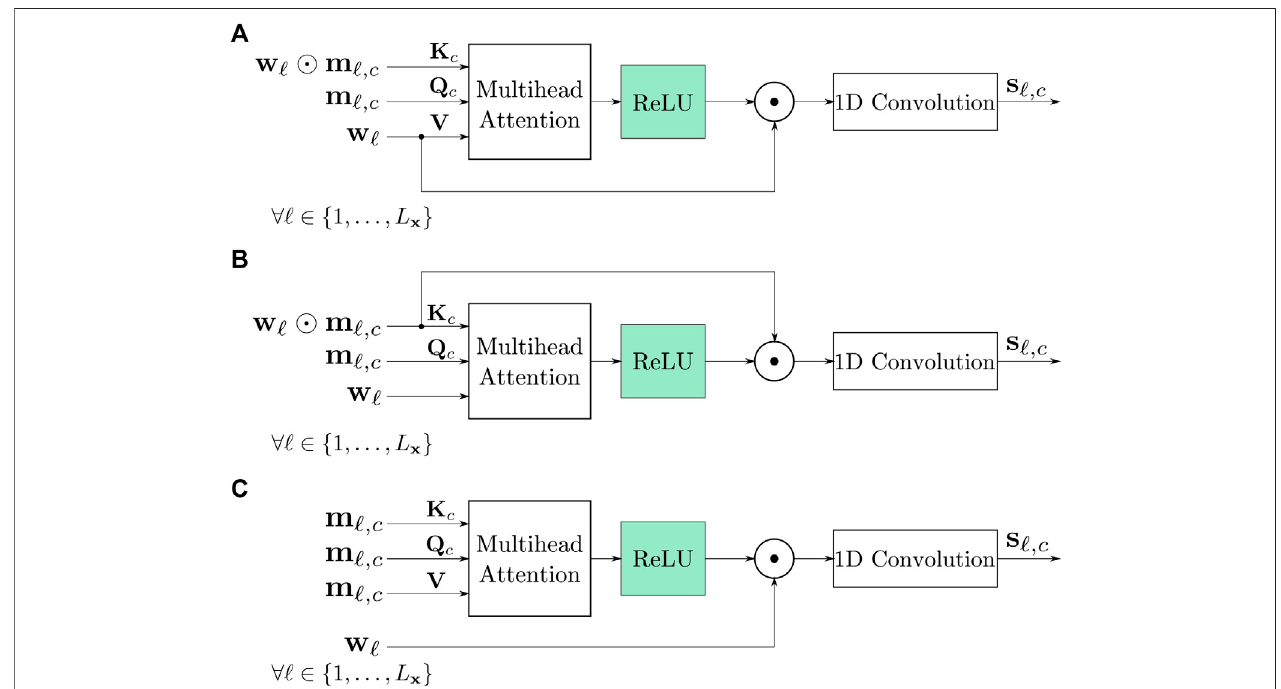
FIGURE 7 | (A) MHA mask re fi nement (MR) decoder architecture. (B) MHA post-masking (PM) decoder architecture. (C) MHA self-attention (SA) decoder architecture.